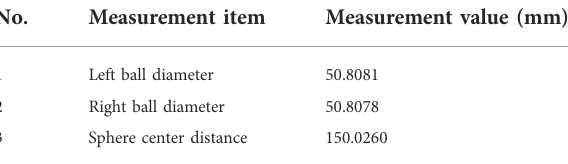
TABLE 2 Results of the sphere center distance of the high-precision three-coordinate measuring machine. No.